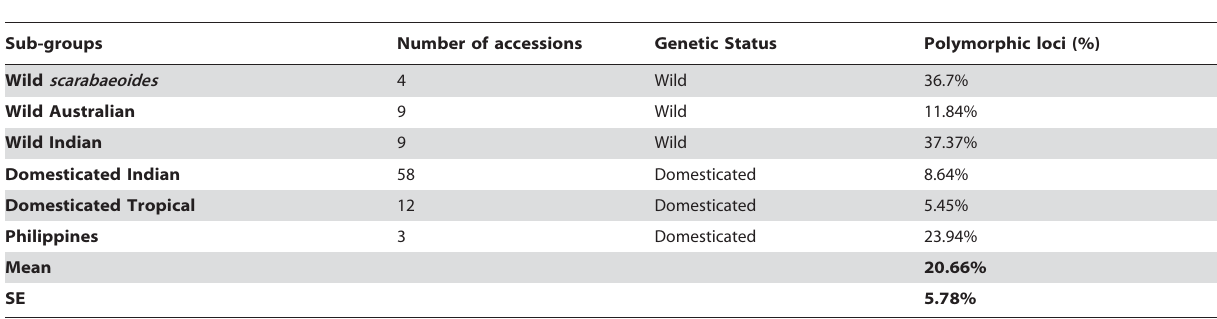
Table 2. Percentage of Polymorphic loci in wild and domesticated groups.